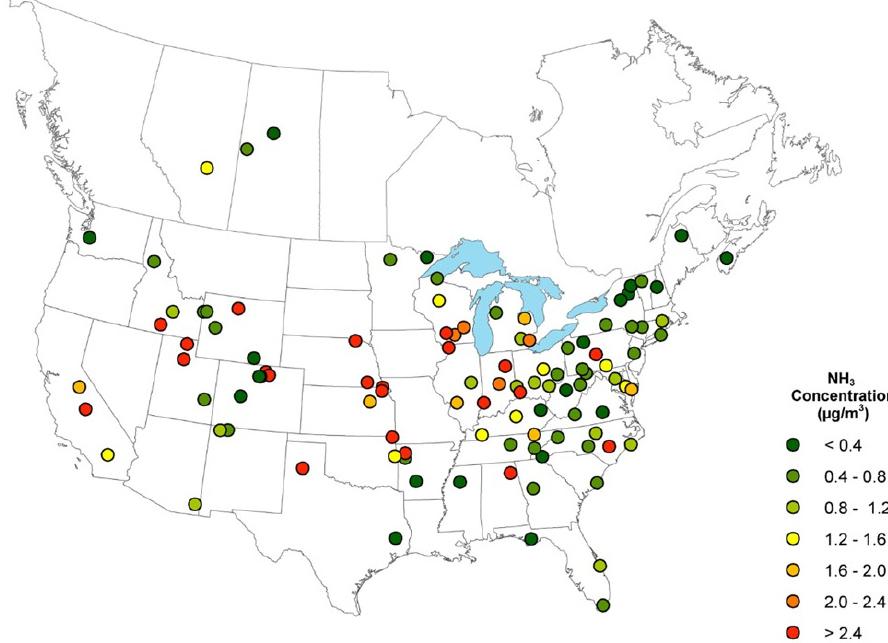
Figure 1. Mean surface NH 3 concentrations across the USA and Canada in 2020 [24].